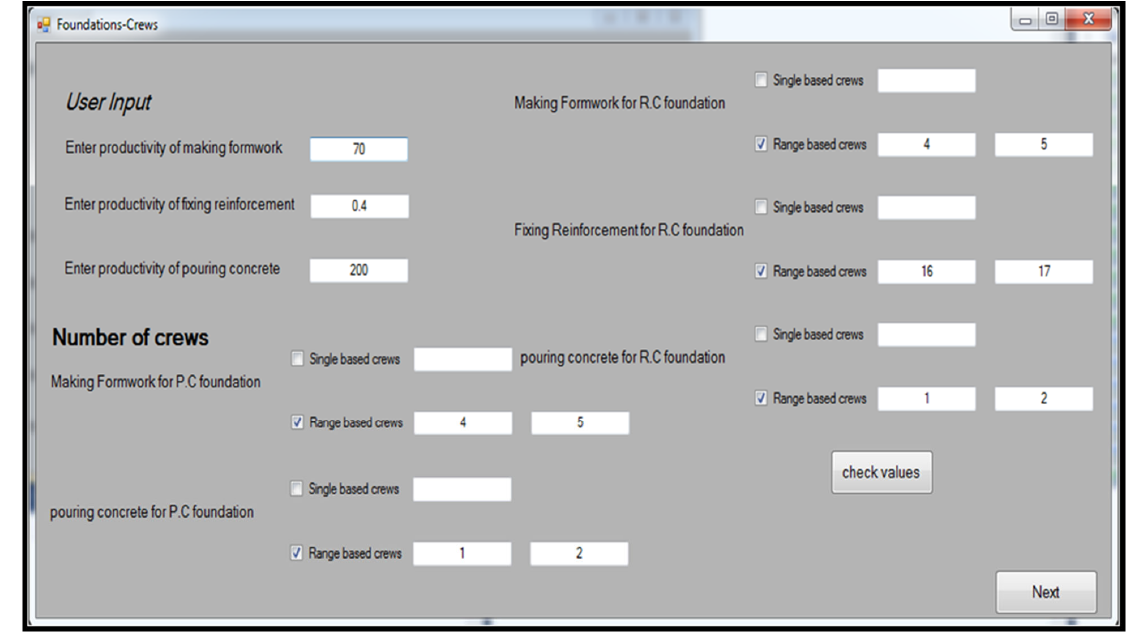
Fig. 5. Interface of user input for time module